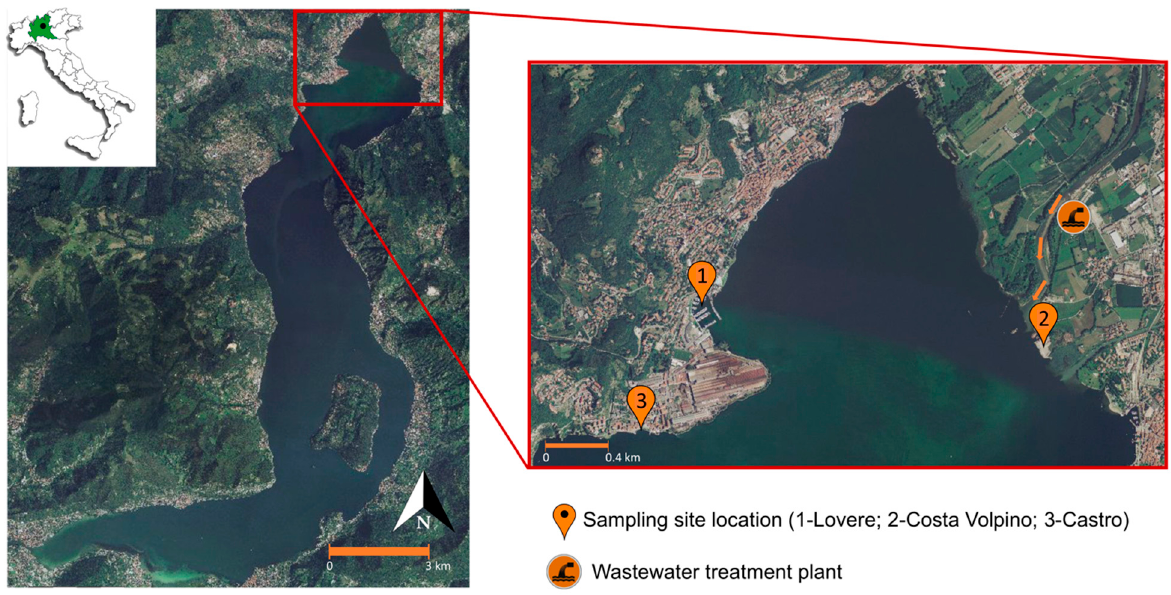
Figure 1. Study area: Lake Iseo (north Italy) on the left and detail of the northern end of the lake (on the right). Location of the three sampling sites (1: Lovere; 2: Costa Volpino; 3: Castro) and of the wastewater treatment plant on the Oglio River (orange arrow: Flow direction).